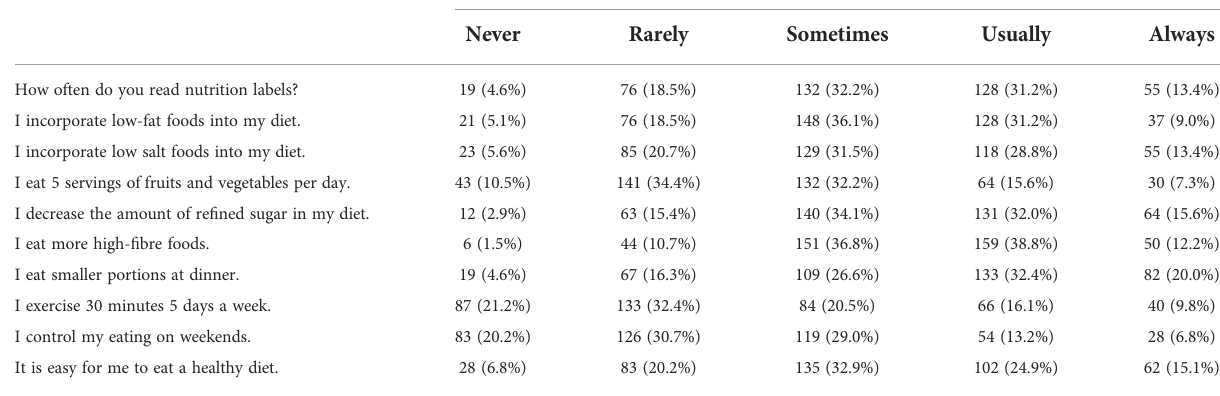
TABLE 4 Responses of respondents to health-related practice statements. Questions for Practices